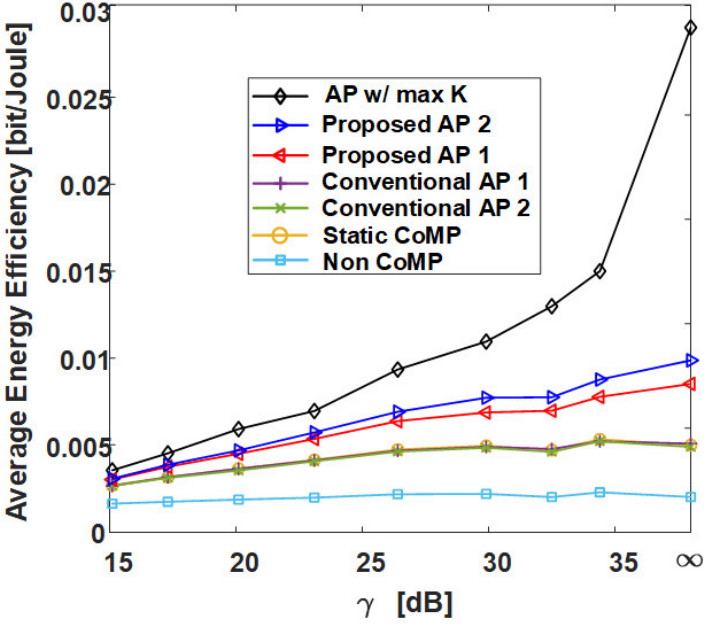
Figure 14. Average energy efficiency of various clustering schemes with respect to γ in grid